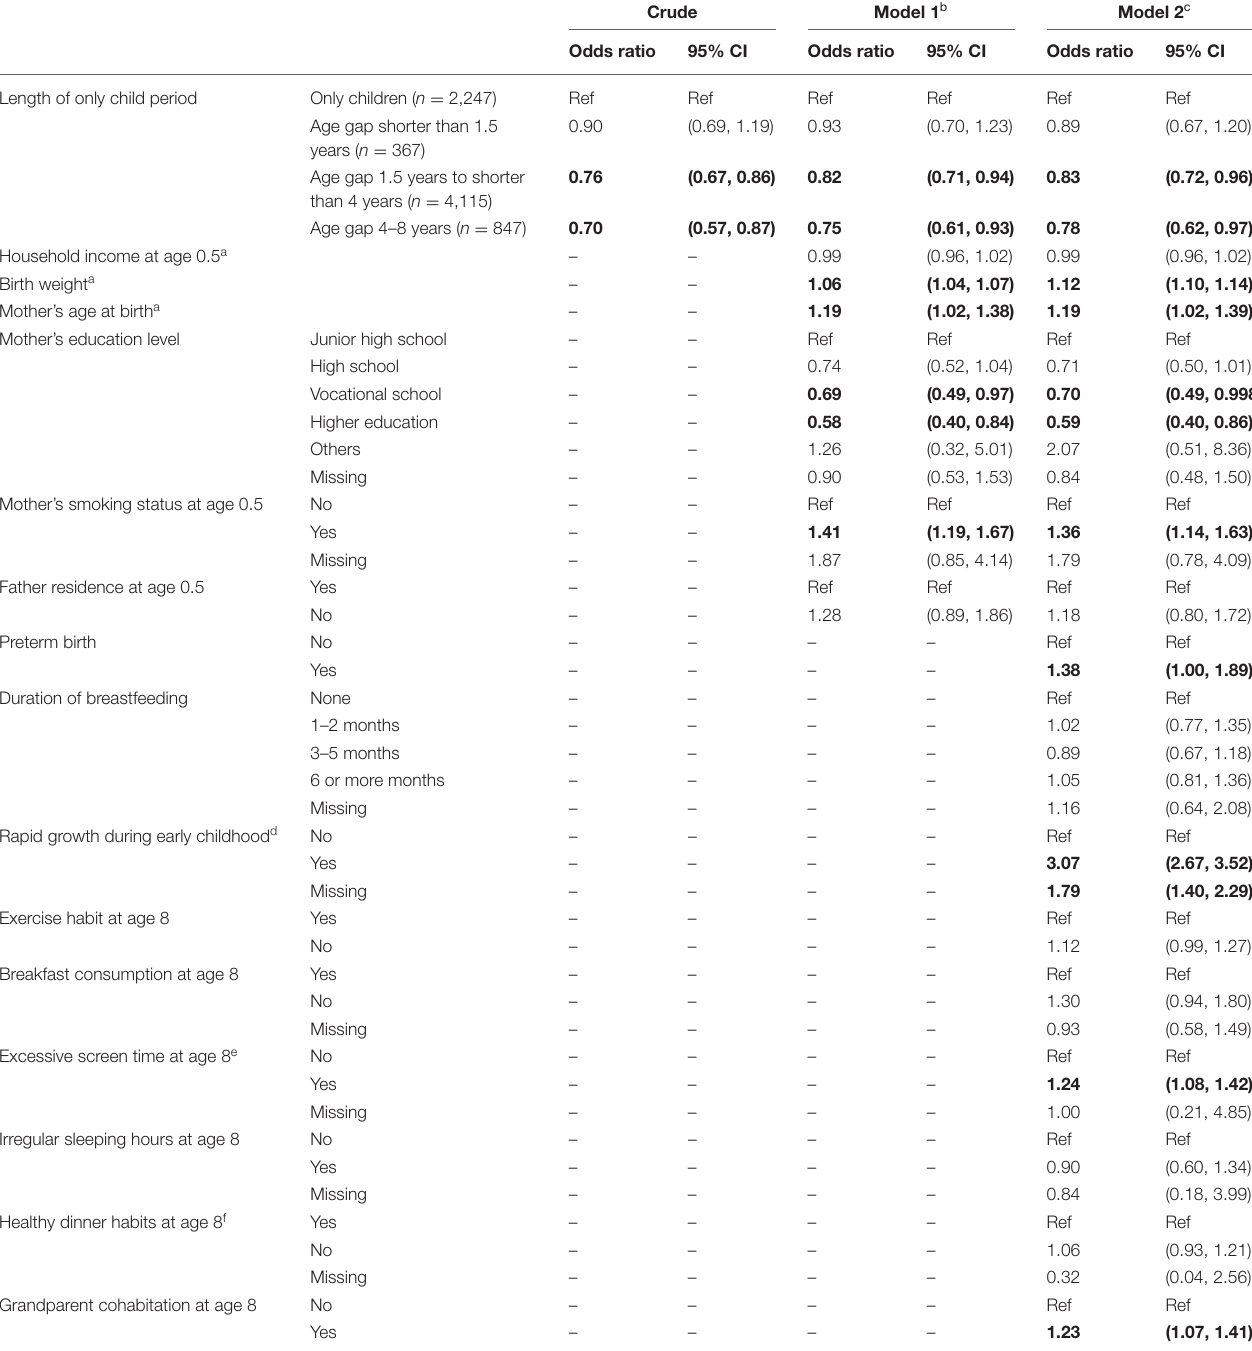
TABLE 4 | Association of length of only-child period and overweight at age 8 among boys, using logistic regression ( n =